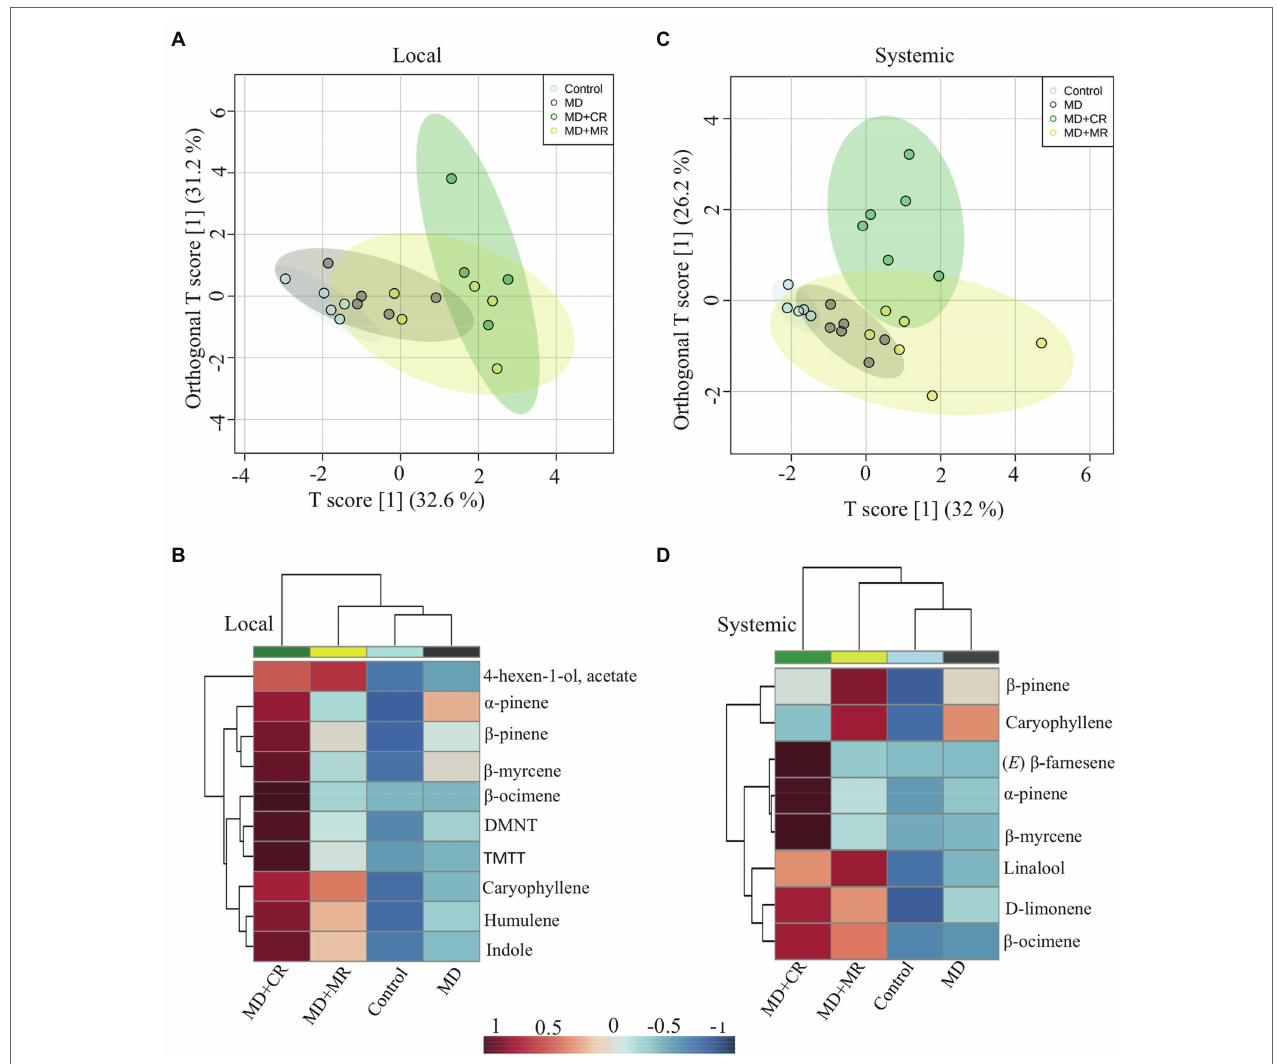
FIGURE 4 | Differences in local and systemically emitted volatiles by cotton plants in response to elicitation by different caterpillar regurgitant. Plants were subjected to the following treatments: undamaged (Control), mechanically damaged (MD), and application of regurgitant of cotton-fed S. exigua (MD + CR), and mechanically damaged and application of regurgitant of maize-fed S. exigua (MD + MR; n = 4–6). The HIPVs were collected after 48 h of elicitation. (A) Results of a orthogonal partial least squares discriminant analysis (OPLS-DA) and (B) hierarchical clustering heatmaps of the local emission of volatiles by cotton plant treated with different regurgitants. (C) Results of a discriminant analysis (OPLS-DA) and (D) hierarchical clustering heatmaps of the systemically emitted volatiles by cotton after treatment with different